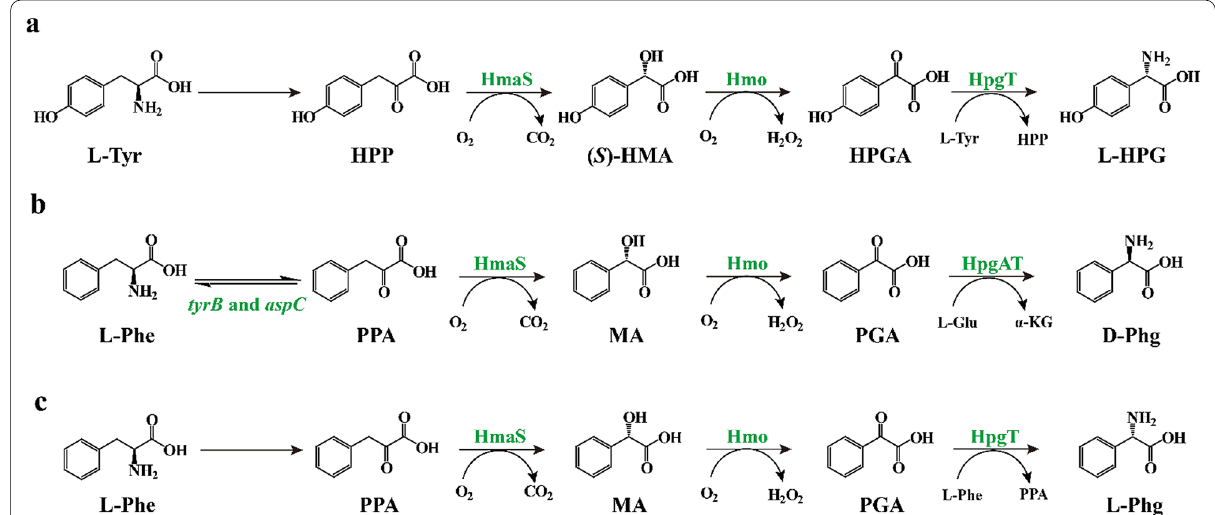
Fig. 1 Biosynthetic pathway of phenylglycine analogues. a Biocatalysis of l -tyrosine to L-HPG. b Biocatalysis of L-Phe to D-Phg. c Biocatalysis of L-Phe to